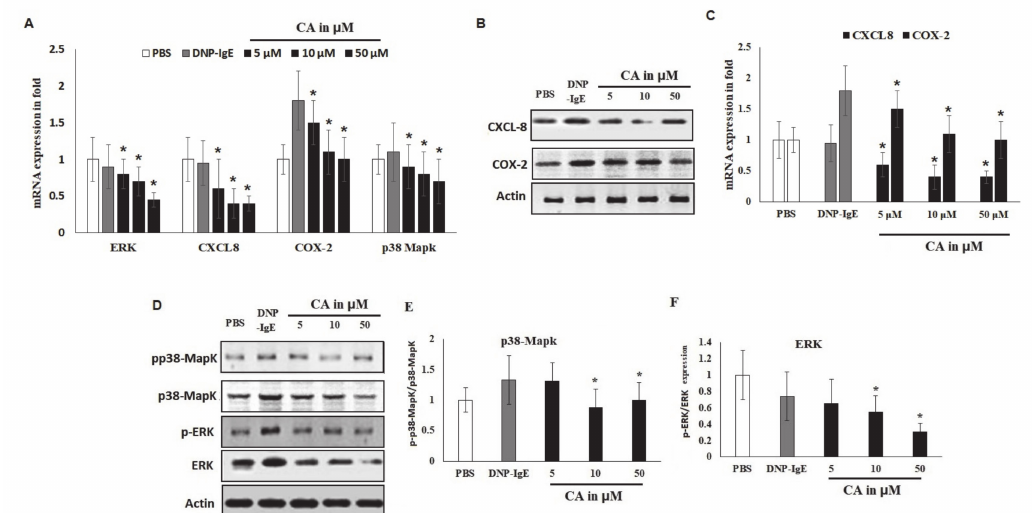
Figure 5. Cinnamaldehyde (CA) e ff ect on allergic markers using in vitro models. ( A ) PCR mRNA quantification of ERK, CXCL-8, COX-2, and p38-MAPK markers in DNP-IgE-sensitized mast cell lines with β -Actin used as an internal control. ( B , C ) Western blot analysis by an immunoblot of CXCL-8 and COX-2 recorded with a LICOR signal recorder. The blot was segregated with ERK and p38 MAPK with and without the phosphorylated form. ( D – F ) p-p38 MAPK and p-ERK protein estimation was noted in Dinitrophenyl (DNP)-IgE-sensitized mast cell lines, with data presented as the results of three independent replicate experiments, mean ± S.D. Significant di ff erence is represented as * p <